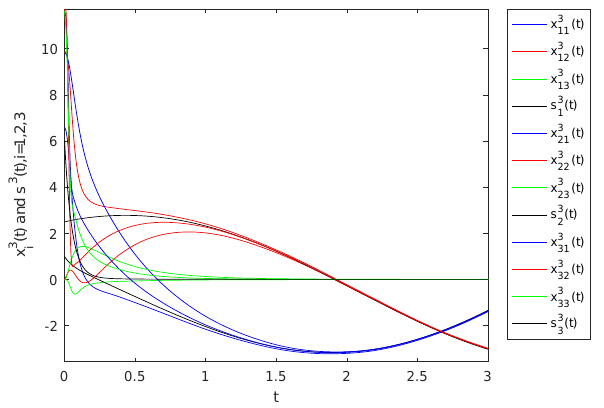
( 3 ) ( t ) and s ( 3 ) ( t ) under Controller (4). ı